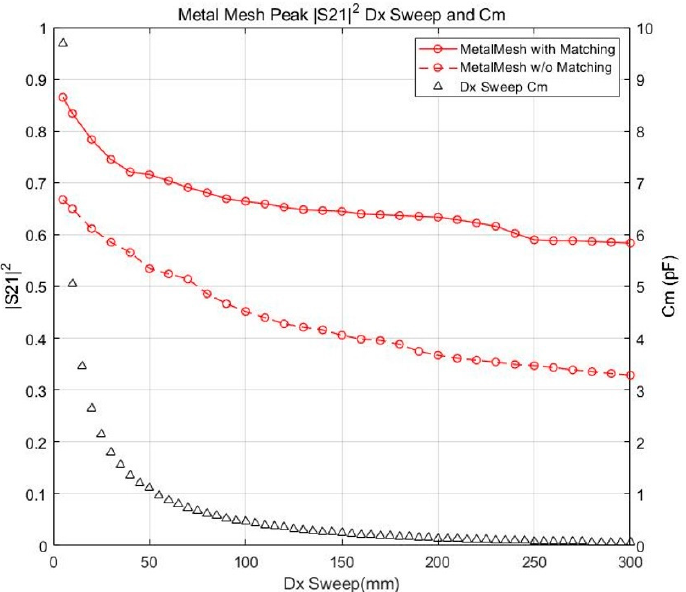
Figure 11. Efficiency and mutual capacitance variation under distance ( D x ) sweep: 5–300 mm.